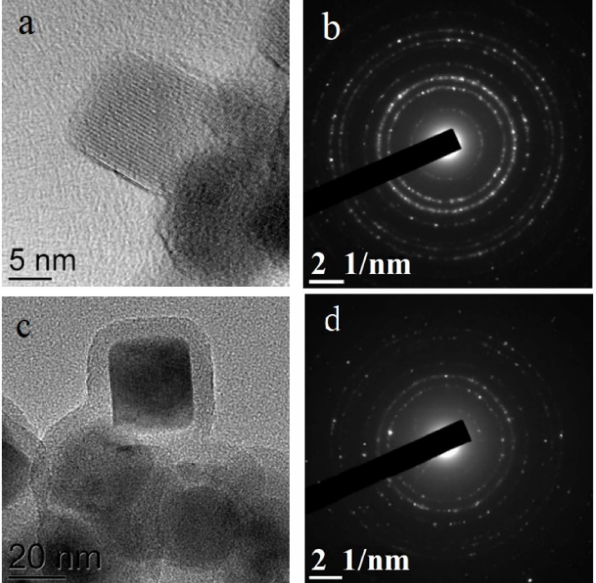
Figure 3. HRTEM image and selected area electron diffraction (SAED) of Fe 3 O 4 ( a , b ) and Fe 3 O 4 @SiO 2 - NH 2 ( c , d ) NPs,